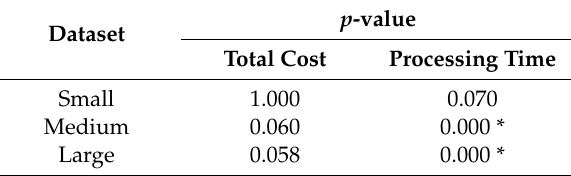
Table 8. Result of paired t -test from all datasets.